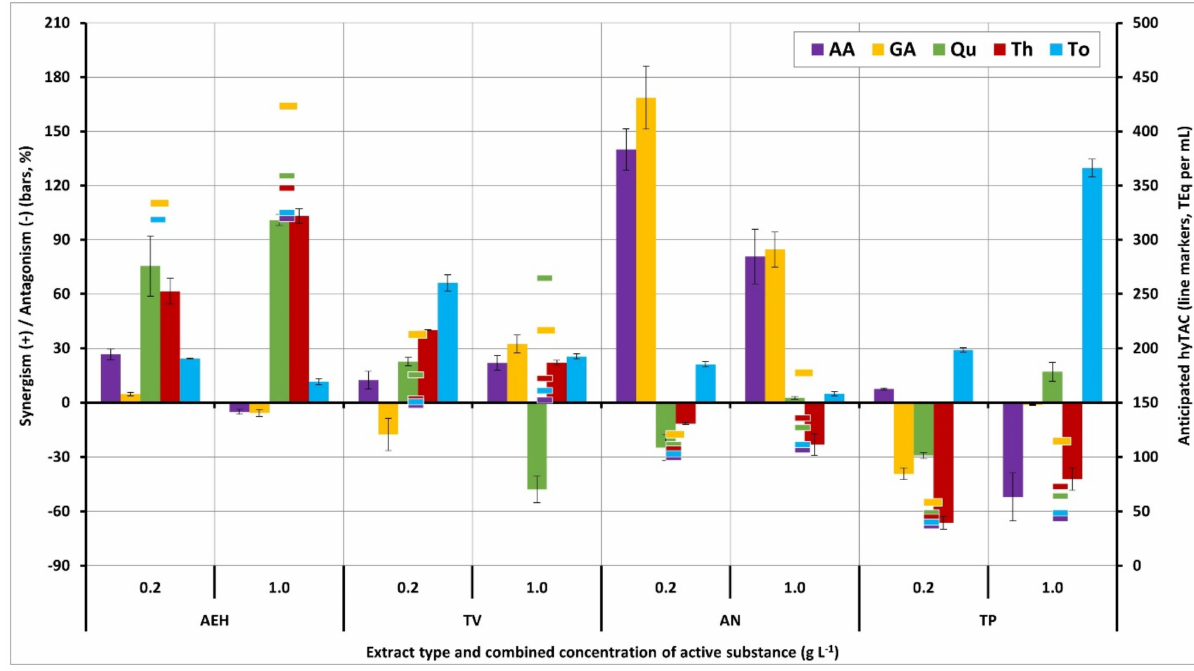
Figure 7. Base total antioxidant capacity (TAC) and determined synergistic effects of different plant-based extracts in combination with active standard substances, analysed via hyTAC Assay. Primary ordinate (bars): synergistic (+) or antagonistic ( − ) effect of extract combinations ( n = 3; standard deviation indicated via error bars). Secondary ordinate (line markers): absolute base TAC, based on TAC determination of pure extracts/standard solutions ( n = 6) and subsequent mathematical accumulation. AA: ascorbic acid; GA: gallic acid; Qu: quercetin; Th: thymol; To: α -tocopherol; AN: